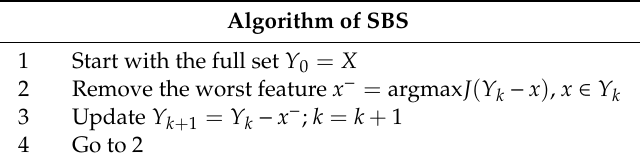
Table 3. Sequential-forward-selection (SBS) procedure.